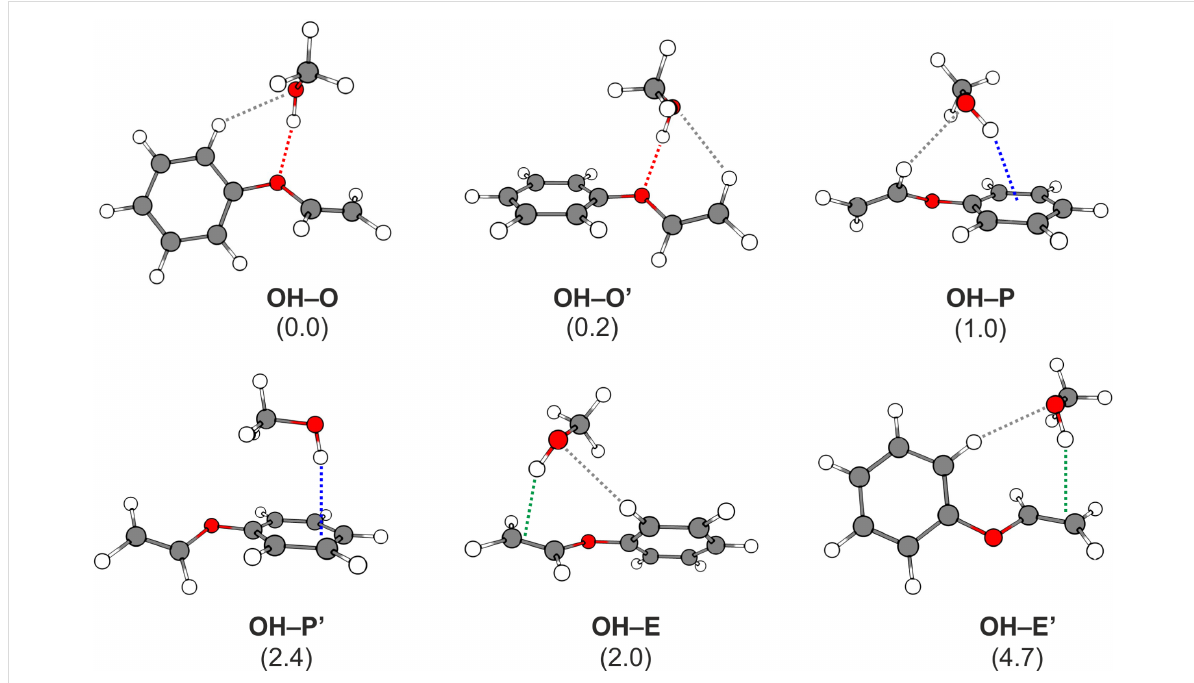
Figure 1: Minimum structures of the most stable PVE–MeOH dimers obtained at the B3LYP-D3(BJ)/def2-TZVP level; dashed colored lines indicate the different primary docking motifs, dashed gray lines illustrate secondary CH–O contacts; values in parentheses correspond to the relative, zero- point-corrected energies E 0,rel with respect to the OH–O isomer, calculated at the LCCSD(T0)-F12/CBS[T:Q]//B3LYP-D3/def2-TZVP level of theory (cf . Table 1).